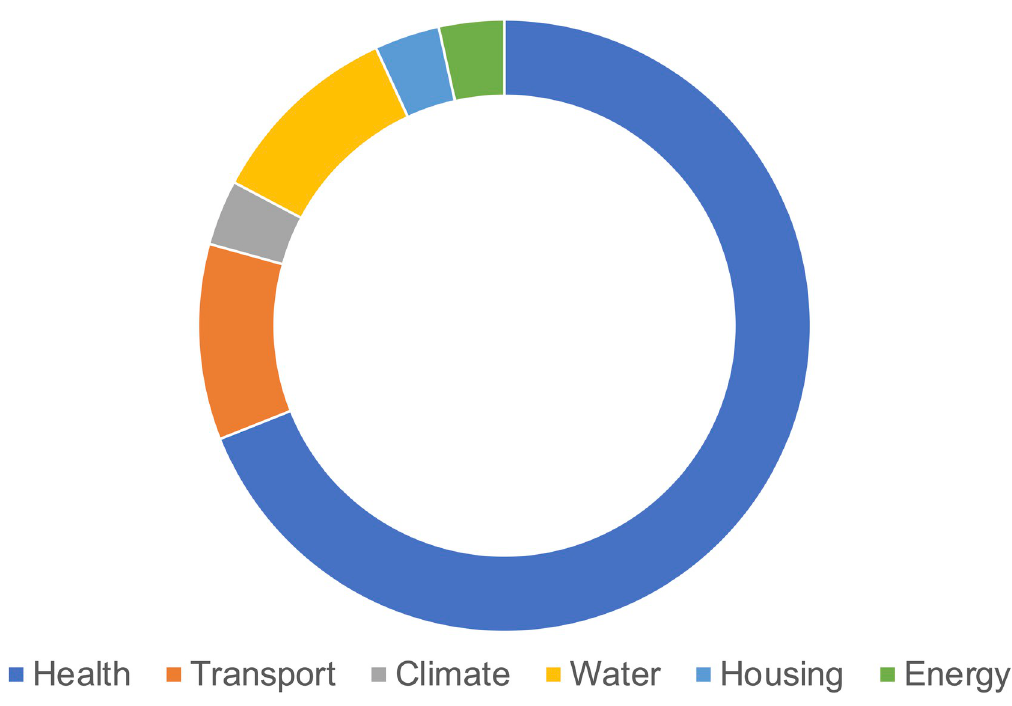
Fig 3. Number of studies by type of public